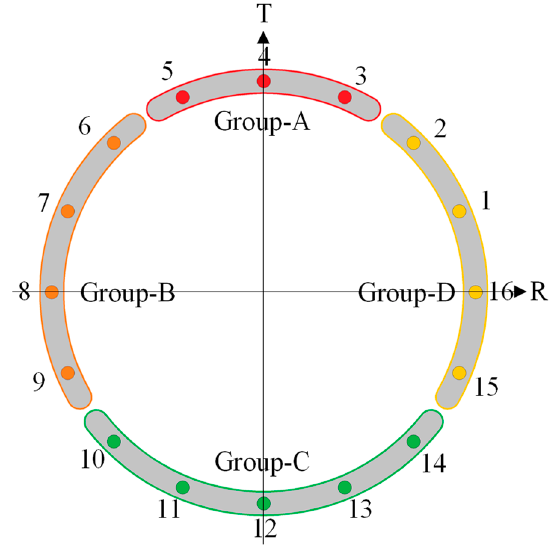
Figure 10. Layout of Jack Thrust.